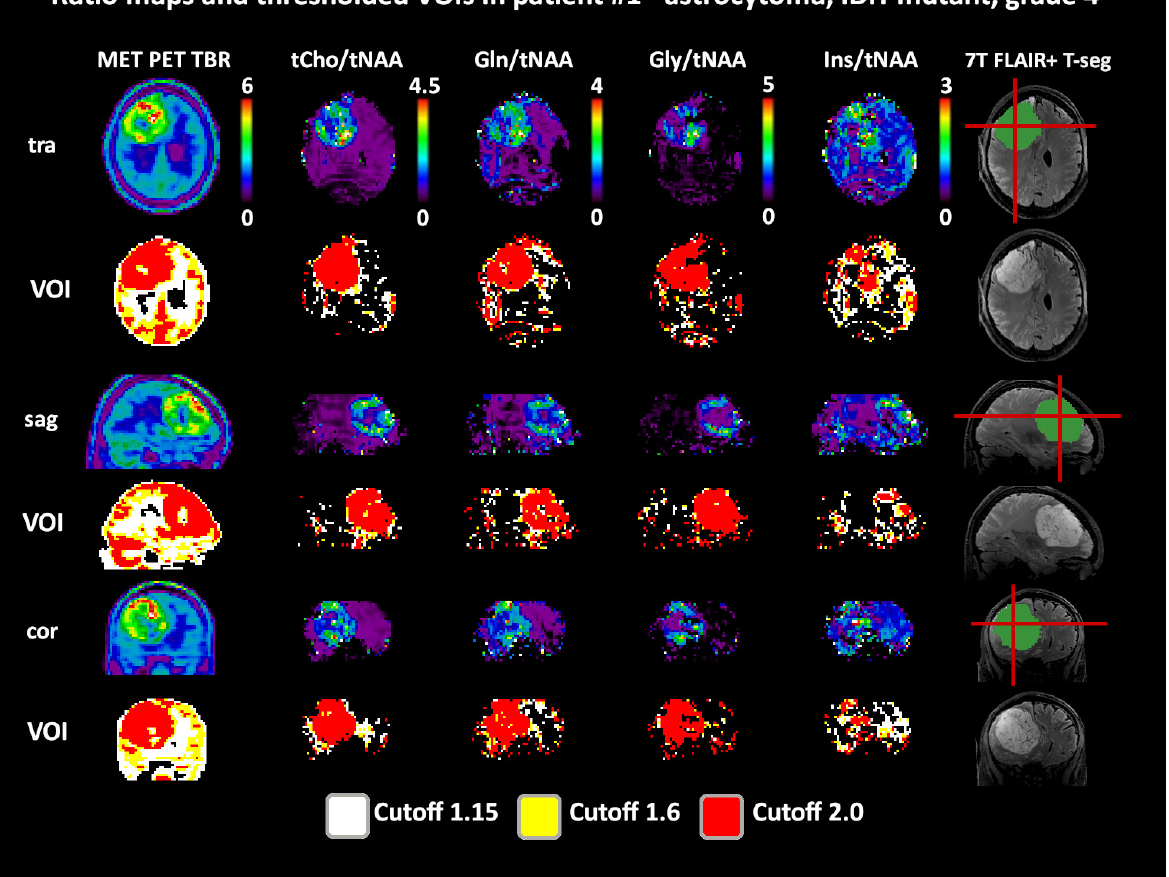
Figure 4. Example images of a patient with a high intratumoral correspondence between PET and MRSI ratios to tNAA (DSCs for TSEG1.6: 0.91/0.89/0.88/0.54 for tCho/Gln/Gly/Ins). Notably, the difference between the 1.6 and 2.0 cutoffs for the MRSI ratios is minimal. The actual evaluation as performed only within the defined tumor segmentations is shown in green. PET maps were resampled to MRSI resolution. Red lines indicate slice positions.